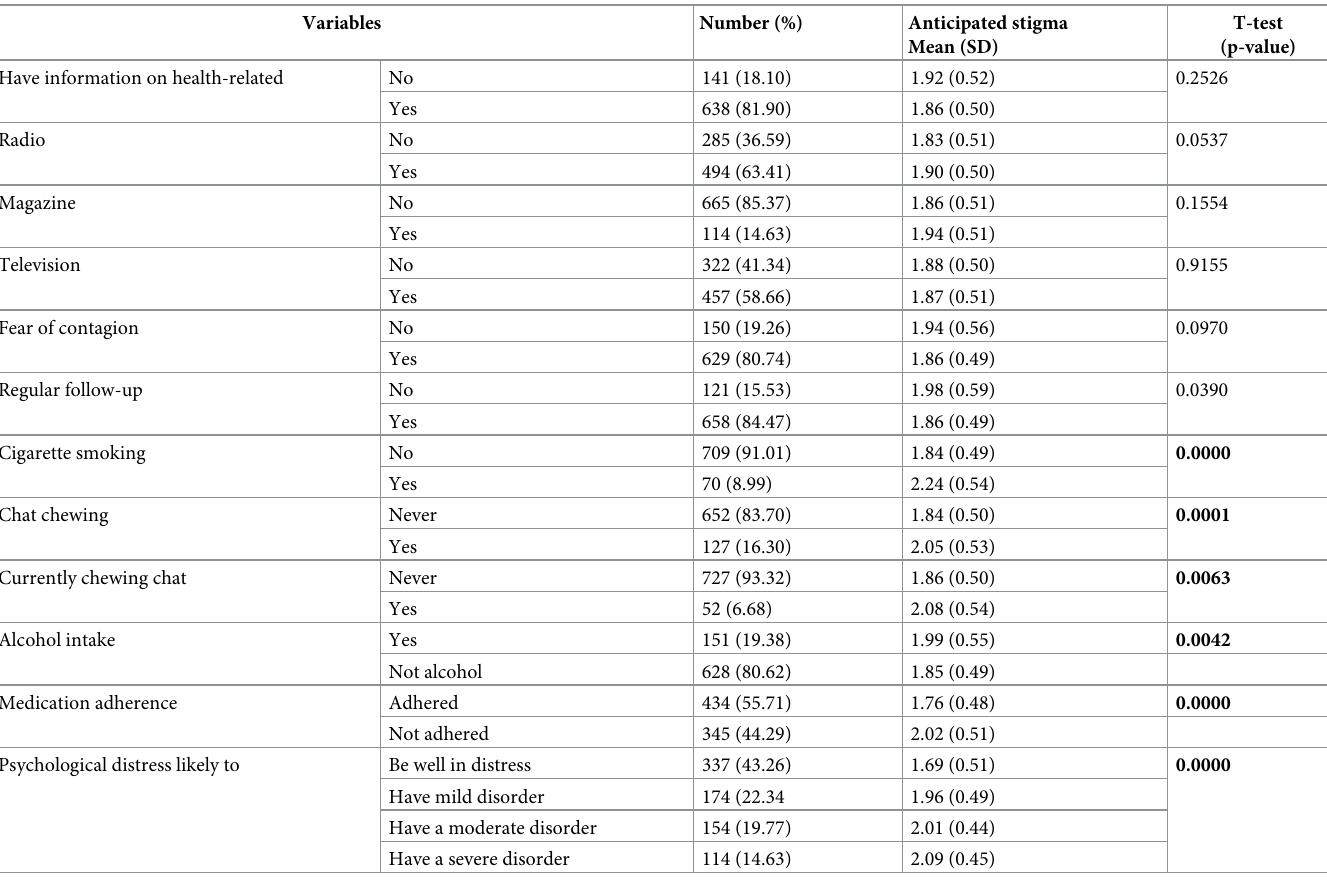
Table 2. Personal and institutional characteristics of patients with chronic illness in three Amhara region Referral Hospitals, Northwest Ethiopia (n = 779).